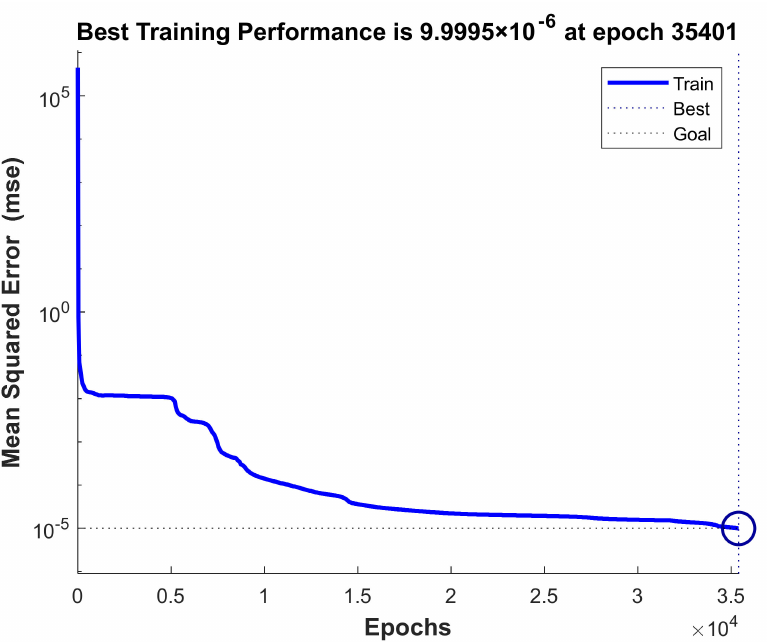
Figure 6. Performance of the proposed ANN